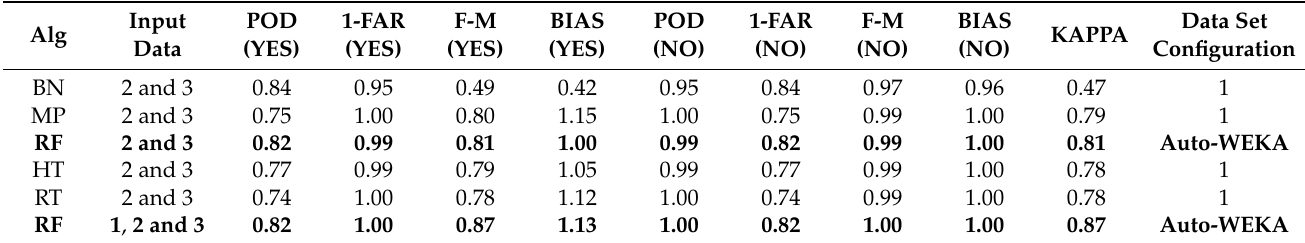
Table 6. Statistical test results of 30 min Vis forecasts ≤ 4500 m for the five algorithms (Alg) selected with input from